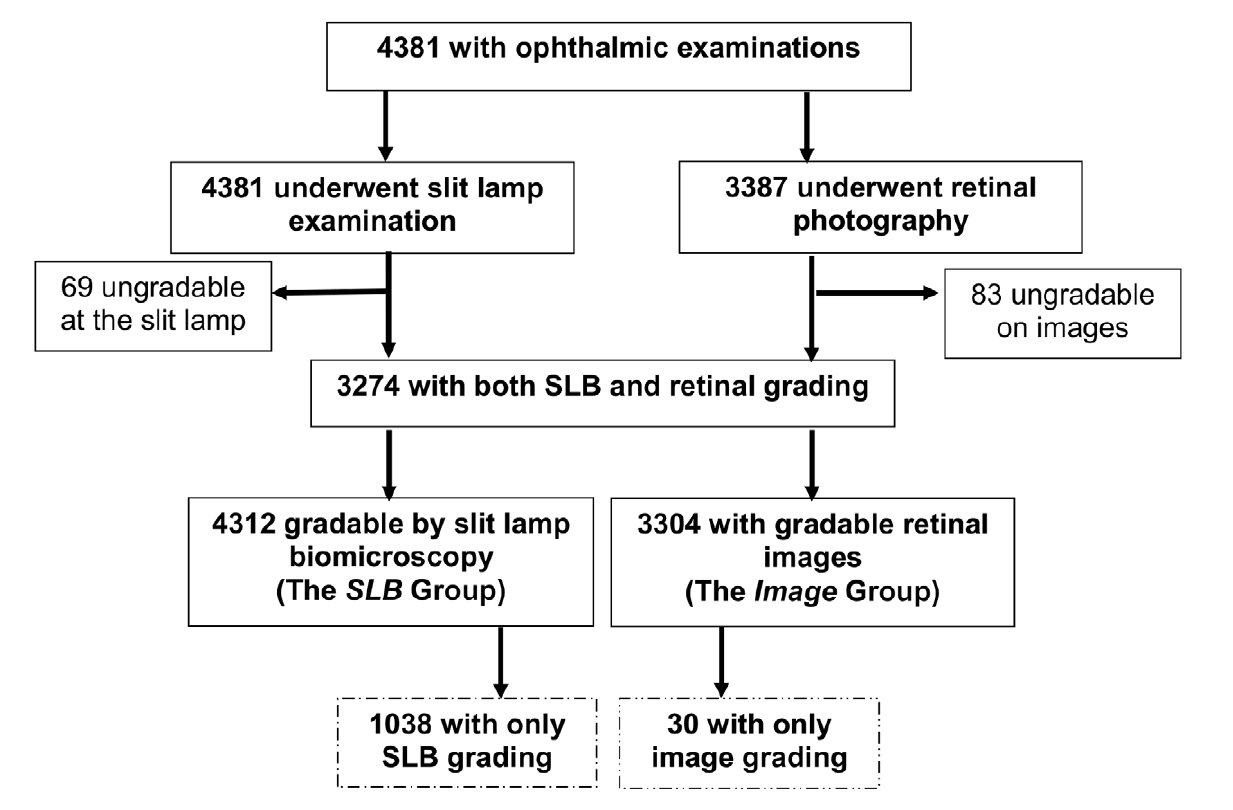
Figure 1. AMD study participation chart.